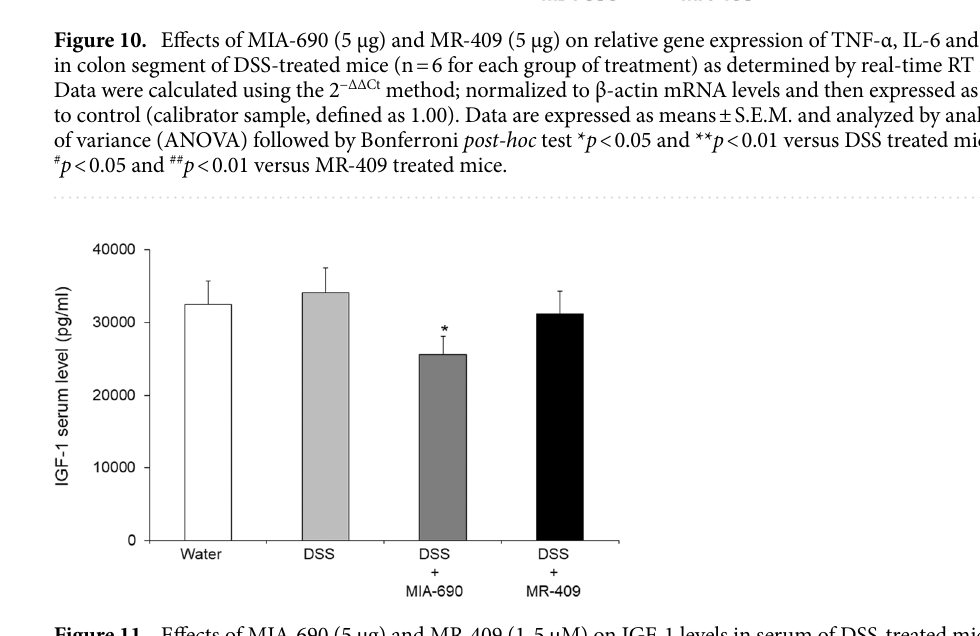
oxidation (redox) status in cancer and other tissues 22,23 . In particular, MIA-690 has proved able to decrease inflammation by suppressing the infiltration of macrophages and leucocytes, and the secretion of TNF-α, IL-1β, and monocyte chemotactic protein-1 (MCP-1) in aqueous humor after insult with LPS 24 . Moreover, MIA-690